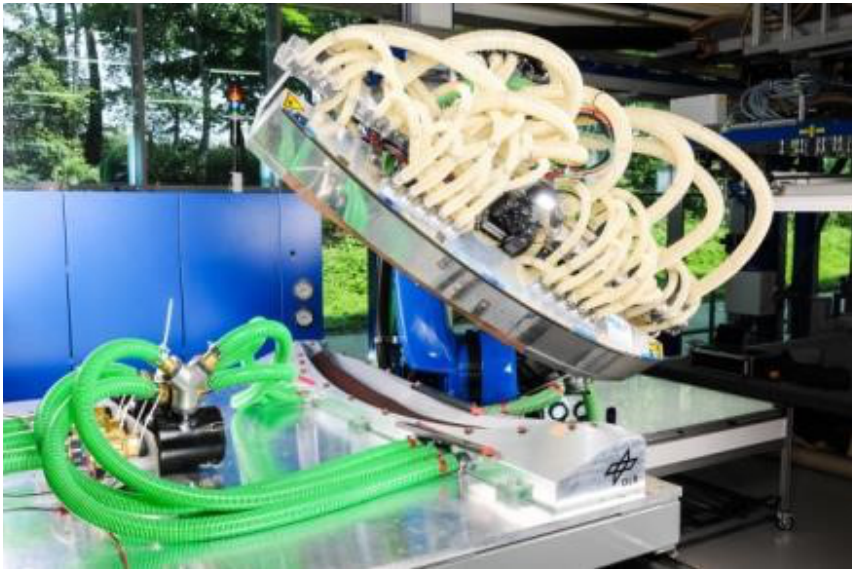
Figure 4: Robot with draping-gripper and